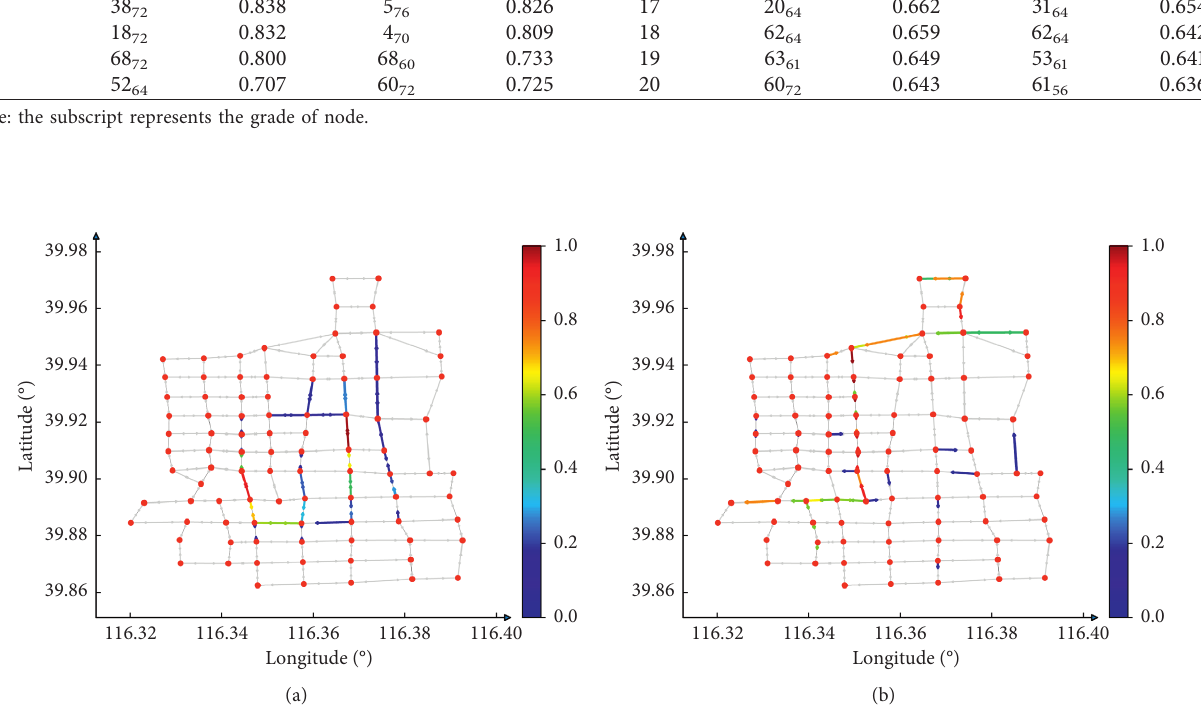
Figure 14: Results of key roadway sections of the comparative method. (a) Identification results based on node betweenness. (b) Identification results based on traffic